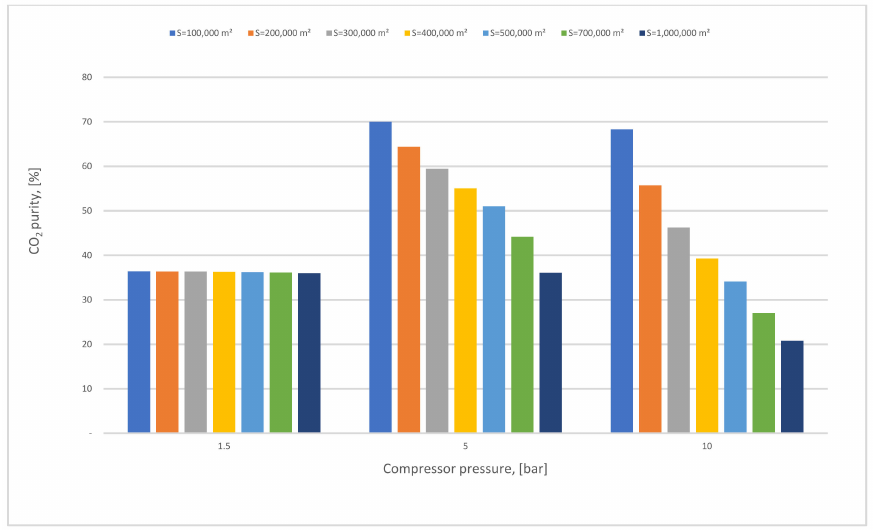
Figure 13. The effect of 1st membrane surface with different 1st compressor pressure on CO 2 purity for 1-stage (case A, B) and 0.5 bar of vacuum pump pressure.